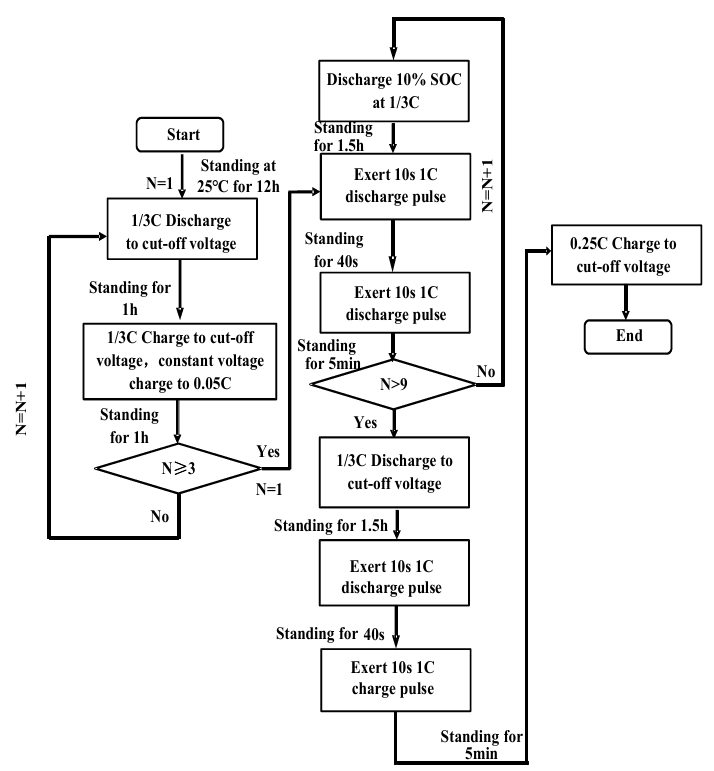
Figure 2. Flowchart of the basic performance tests for the battery.